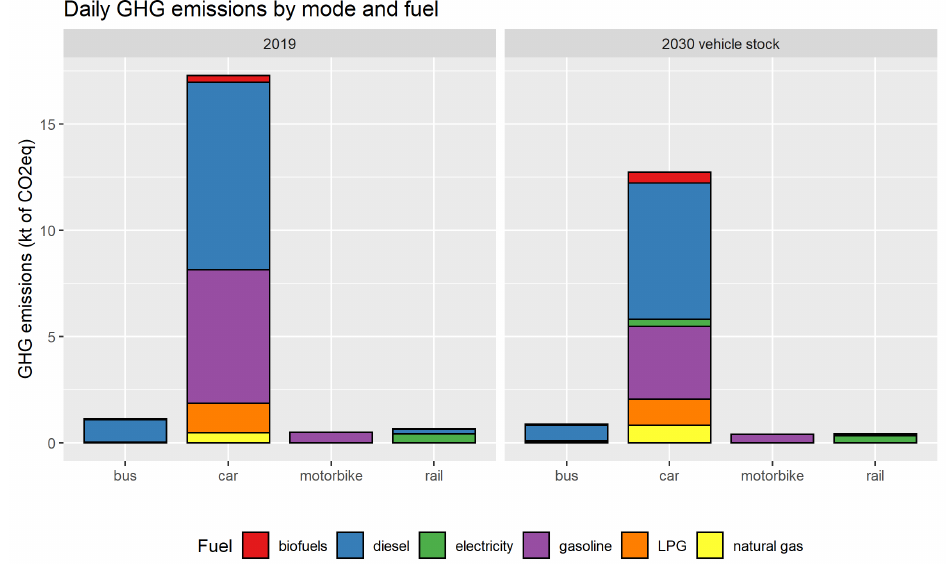
Figure 4. GHG emissions of daily trips by mode in Lombardy, considering a WTW perspective. Emissions by mode and fuel.